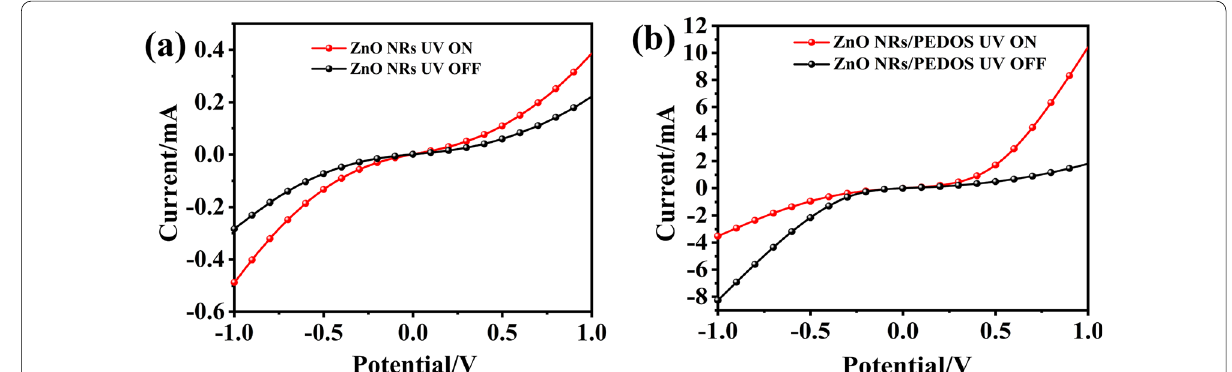
Fig. 4 I–V curves of a ZnO NRs, b ZnO NRs/PEDOS in the dark and under the illuminating at 365 nm UV light